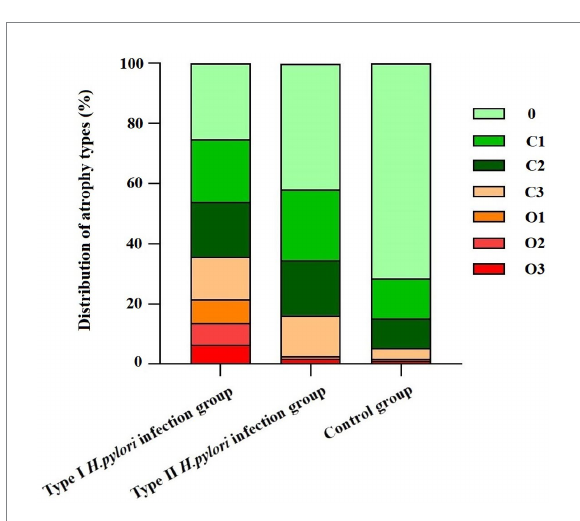
FIGURE 2 Distribution of different types of Helicobacter pylori infection in Kimura–Takemoto